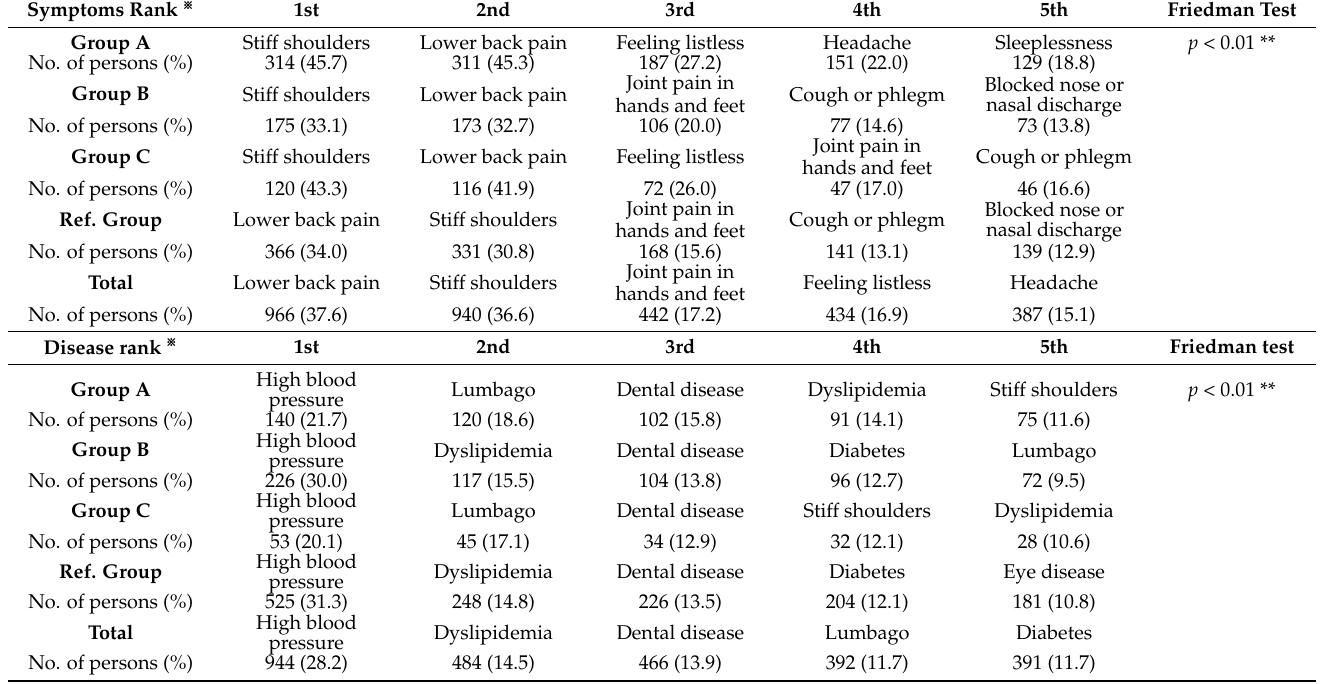
Table 6. Comparison of symptoms and diseases ranked by response